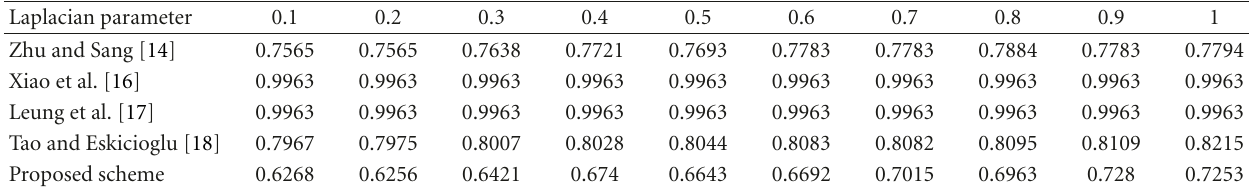
Table 4: Experiment results comparison under Laplacian sharpening (NC values).